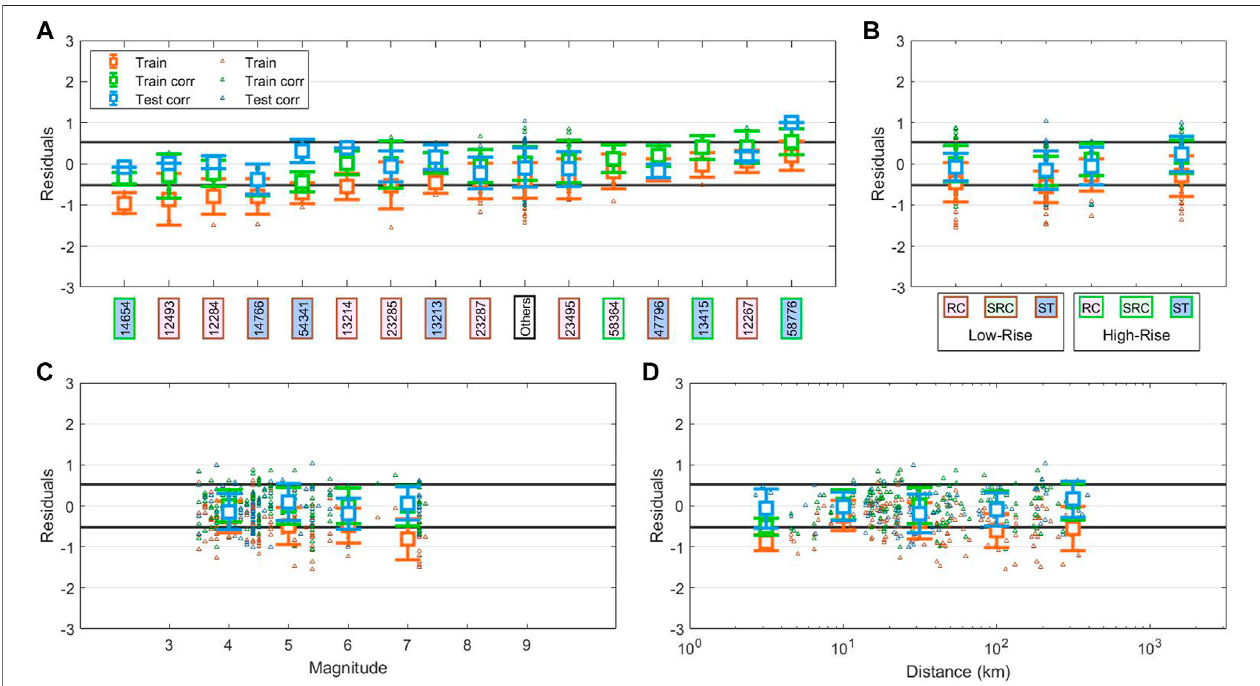
FIGURE 6 | Decomposition of the residuals of Dr. prediction for US dataset using Japanese model. The residuals are computed as real Dr. - predicted Dr., so positive values mean overestimation, and negative residuals mean underestimation. In each panel we show the residuals for LSR IV 2 2s model in three cases: for the training set without corrections, with orange tringles representing the single prediction and orange errorbars representing the mean prediction of the group; for the training set with magnitude dependent correction with green triangles for the single prediction and green errorbars for the group mean; for the testing set with magnitudedependentcorrectionwithlightbluetrianglesforthesinglepredictionandlightblueerrorbarsforthegroupmean.Blacklinesrepresentthe ± σ train forLSRIV 2 2s . Thelabelsinpanels (A) and (B) arecoloredbyconstructiontypeandheight:pinkforRC;lightgreenforSRC;blueforST;brownedgesforlow-rize;greenedgesforhigh- rize. The “ Others ” label is white. In panel (A) we decompose the residuals by buildings. In (B) wegroup them by building type of construction and height. In panel (C) we use themagnitude todecompose residuals, thegroupsareevenly spaced andtheerrorbarsareplacedinthecenterofthebin.Inpanel (D) theresidualsaregroupedby distance in km, the groups are evenly spaced and the errorbars are placed in the center of the bin.